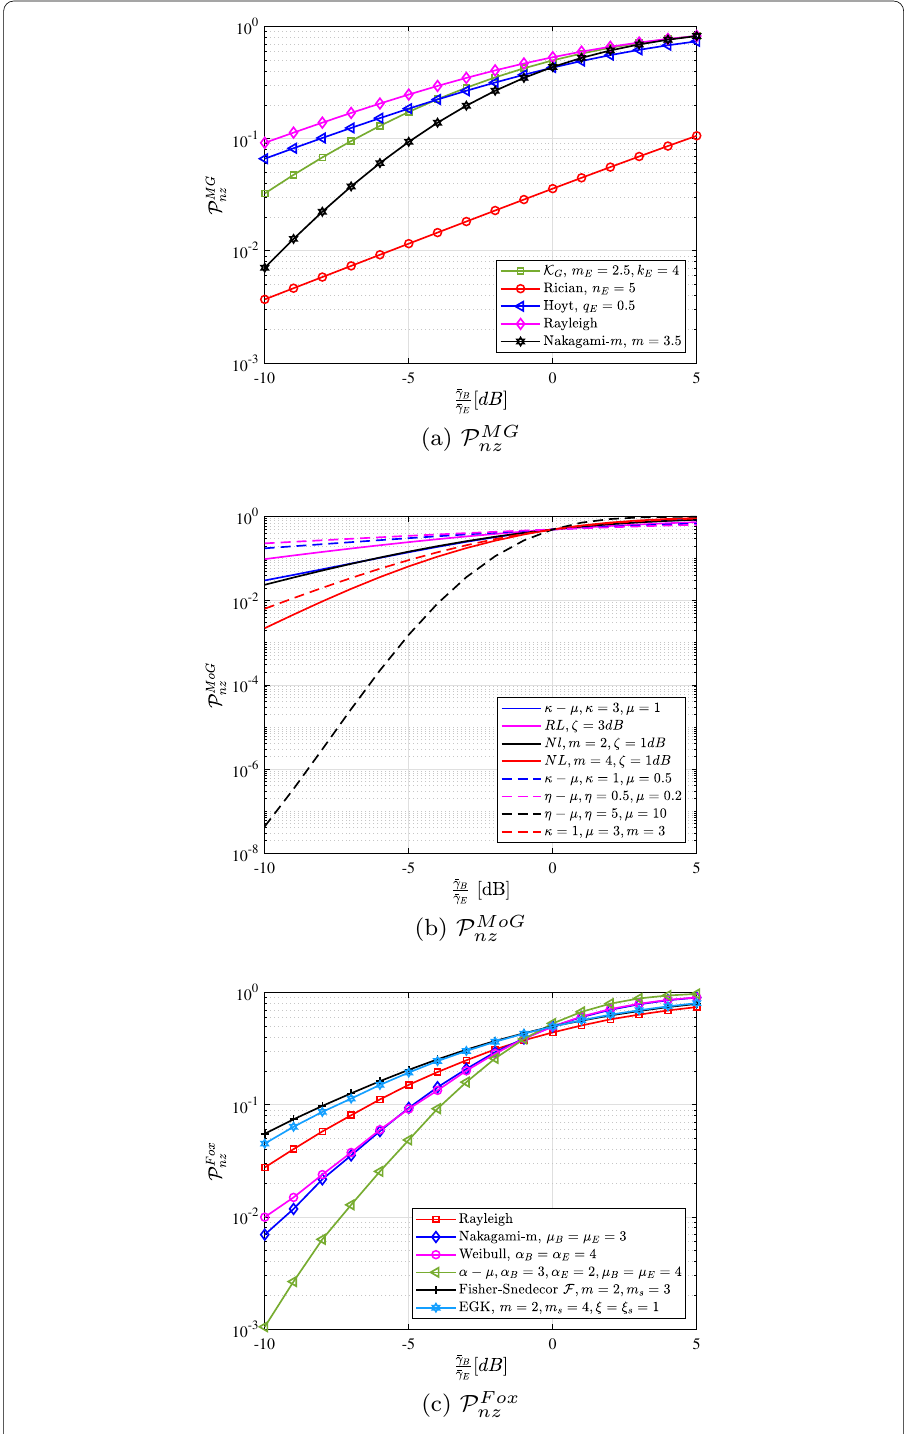
Fig. 2 Illustration of P nz versus ¯ γ B ¯ using the MG, MoG, and Fox’s H -function distributions when ¯ γ E γ E the main channel undergoes K G ( m B = 2.5, k B = 4 ) fading while the wiretap channel experiences K G , Rician, Hoyt, Rayleigh, and Nakagami- m ( m = 3.5 ) fading; b the main and wiretap channels undergo same fading while using the MoG distribution; and c the main and wiretap channels undergo same fading while using the Fox’s H -function